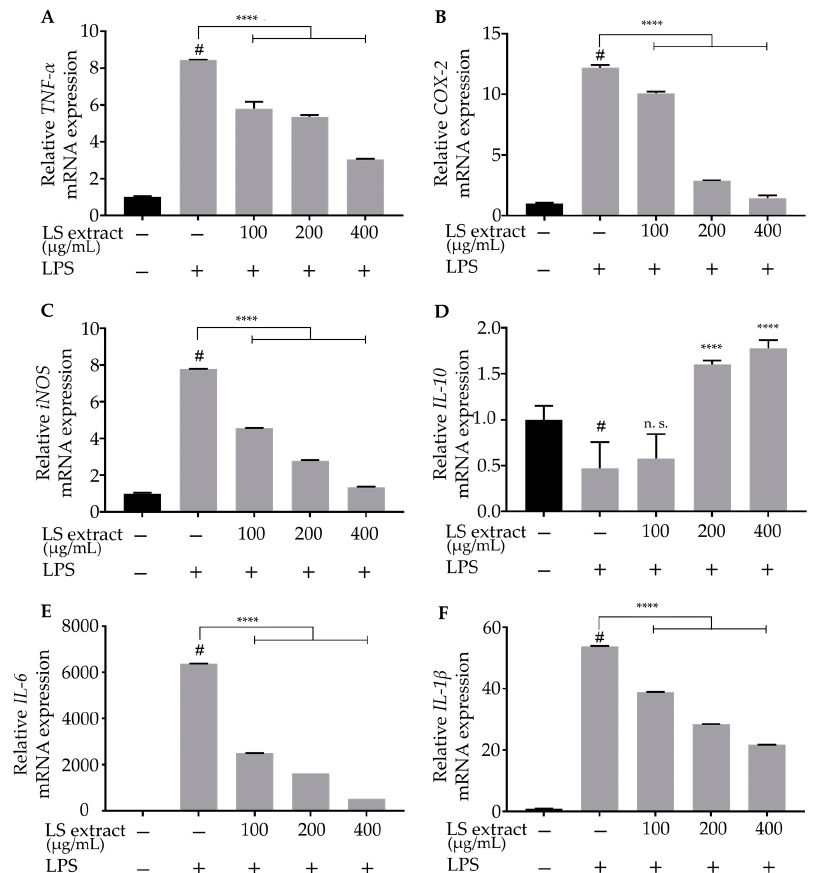
Figure 4. Effects of LS leaf extract on the expression of pro-inflammatory cytokines in LPS-stimulated RAW 264.7 macrophages. RAW 264.7 cells were pretreated with LS leaf extract for 24 h, followed by LPS (1 μ g/mL) stimulation for 18 h. The expression of TNF- α ( A ), cyclooxygenase-2 ( COX-2 ) ( B ), inducible nitric oxide synthase ( iNOS ) ( NOS2 ) ( C ), interleukin-10 ( IL-10 ) ( D ), IL-6 ( E ), and IL-1 β ( F ) was analyzed by qRT-PCR ( n = 3). Values represent the mean ± SD. Statistical significance was calculated by t -test and one-way ANOVA. # p < 0.05 vs. cells treated with media only; n. s., not significant; **** p < 0.0001 vs. cells treated with LPS only.